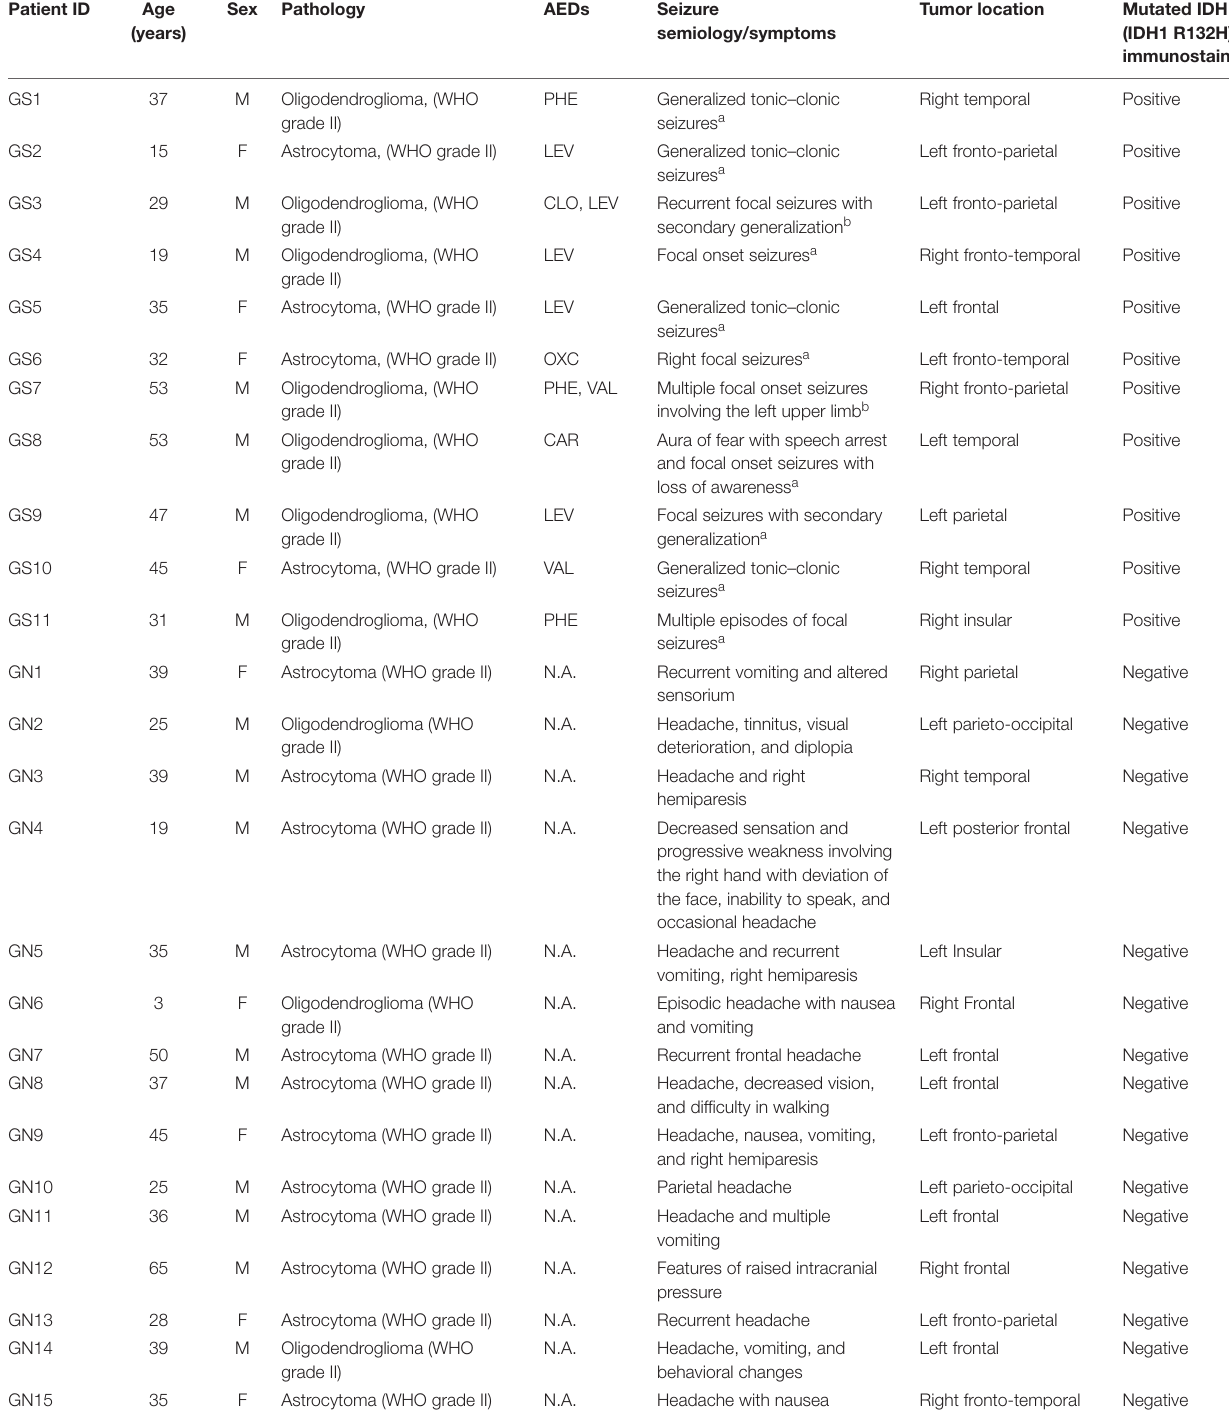
TABLE 1 | Clinical details of low-grade glioma patients with seizures. Patient